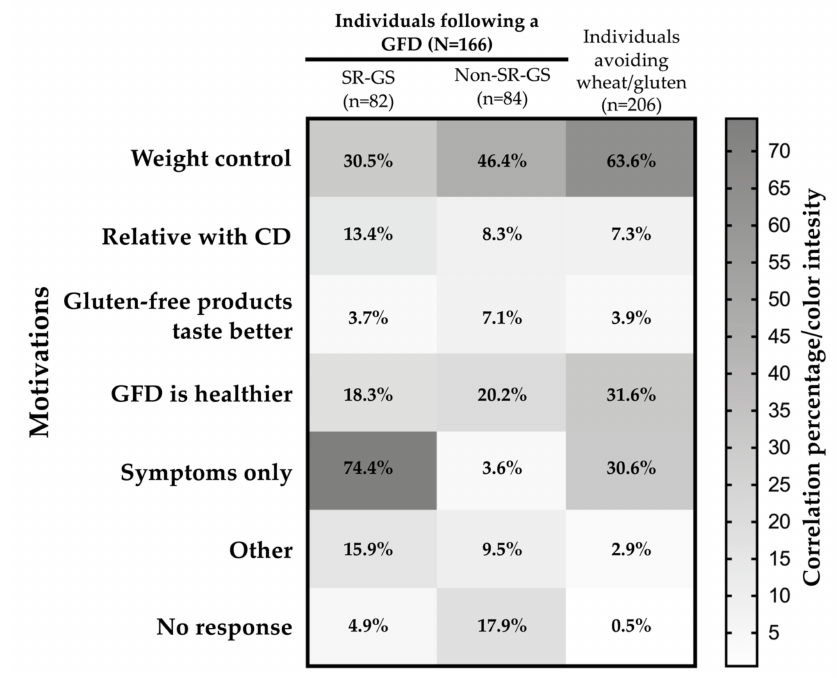
Figure 4. Motivations for following a GFD among SR-GS and non-SR-GS cases, or for avoiding wheat/gluten from the diet among wheat/gluten avoiders. GFD—gluten-free diet; CD—celiac